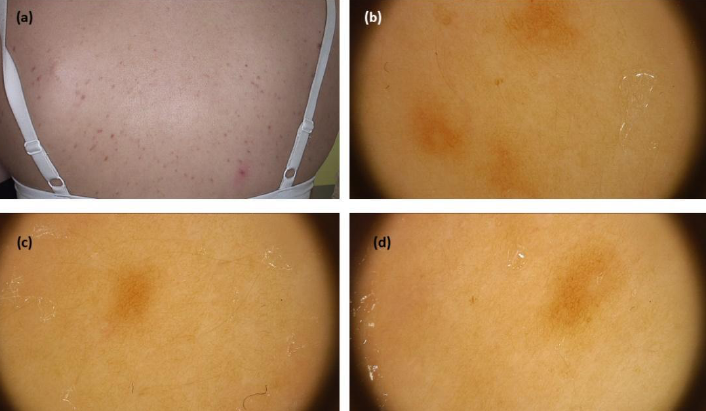
Figure 2. ( a ) Maculopapular cutaneous mastocytosis (urticaria pigmentosa clinical subtype) — clini- cal presentation. ( b – d ) Dermoscopy shows brown reticular lines (pigment network)(FotoFinder, Medicam 800 HD, FotoFinder Systems GmbH, Bad Birnbach, Germany; ×20 magnification, immer- sion gel).